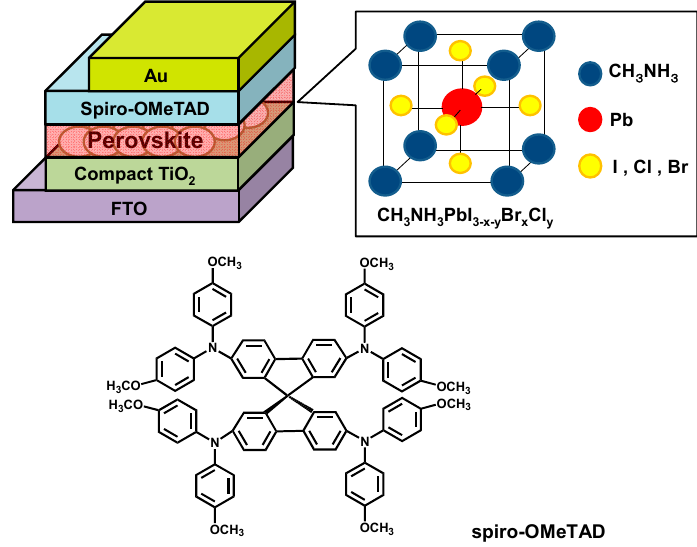
Figure 1. Perovskite solar cell, crystal structure of perovskite and molecular structure of 2,2 ′ ,7,7 ′‐ tetrakis ‐ ( N,N ‐ di ‐ 4 ‐ methoxyphenylamino) ‐ 9,9 ′‐ spirobifluorene (spiro ‐ OMeTAD).